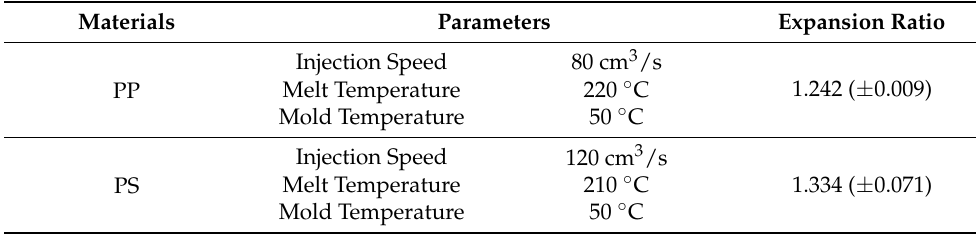
Table 11. Expansion ratios with the optimal process parameter